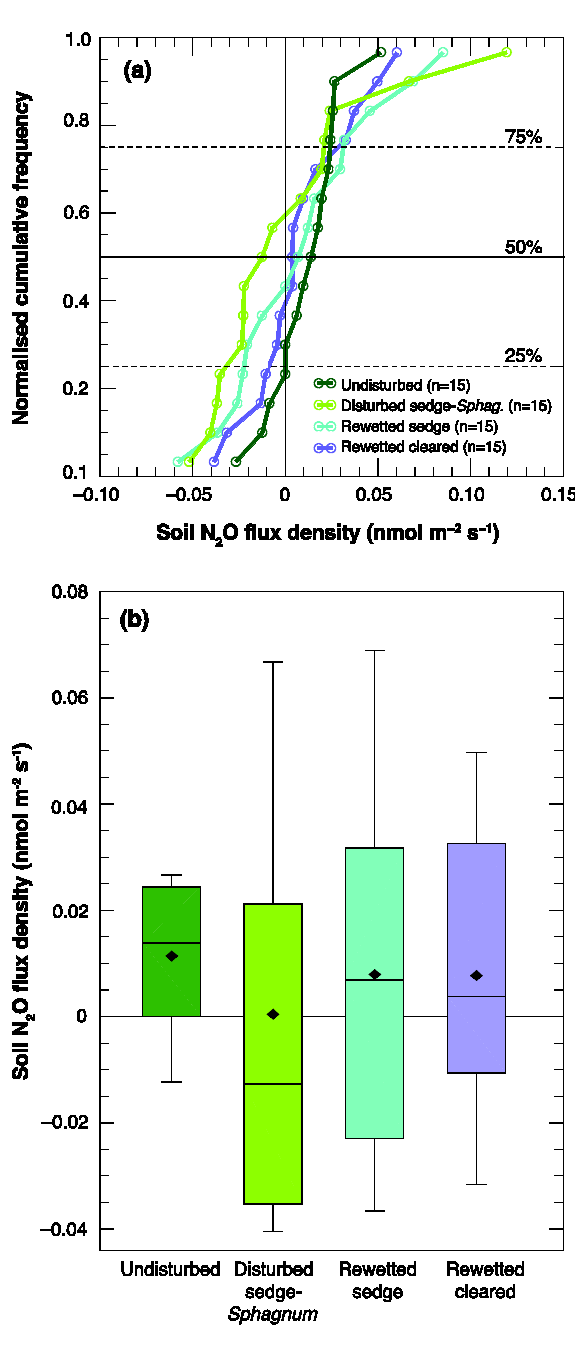
Figure 8. (a) Cumulative frequency distributions of all individual nitrous oxide (N 2 O) fluxes (all sites and all collars). Data from 17–18 July, 24–28 July and 11 August 2014 are included. (b) Distribution of soil N 2 O flux measurements (all sites and all collars). Data from 17–18 July, 24–28 July and 11 August 2014 are